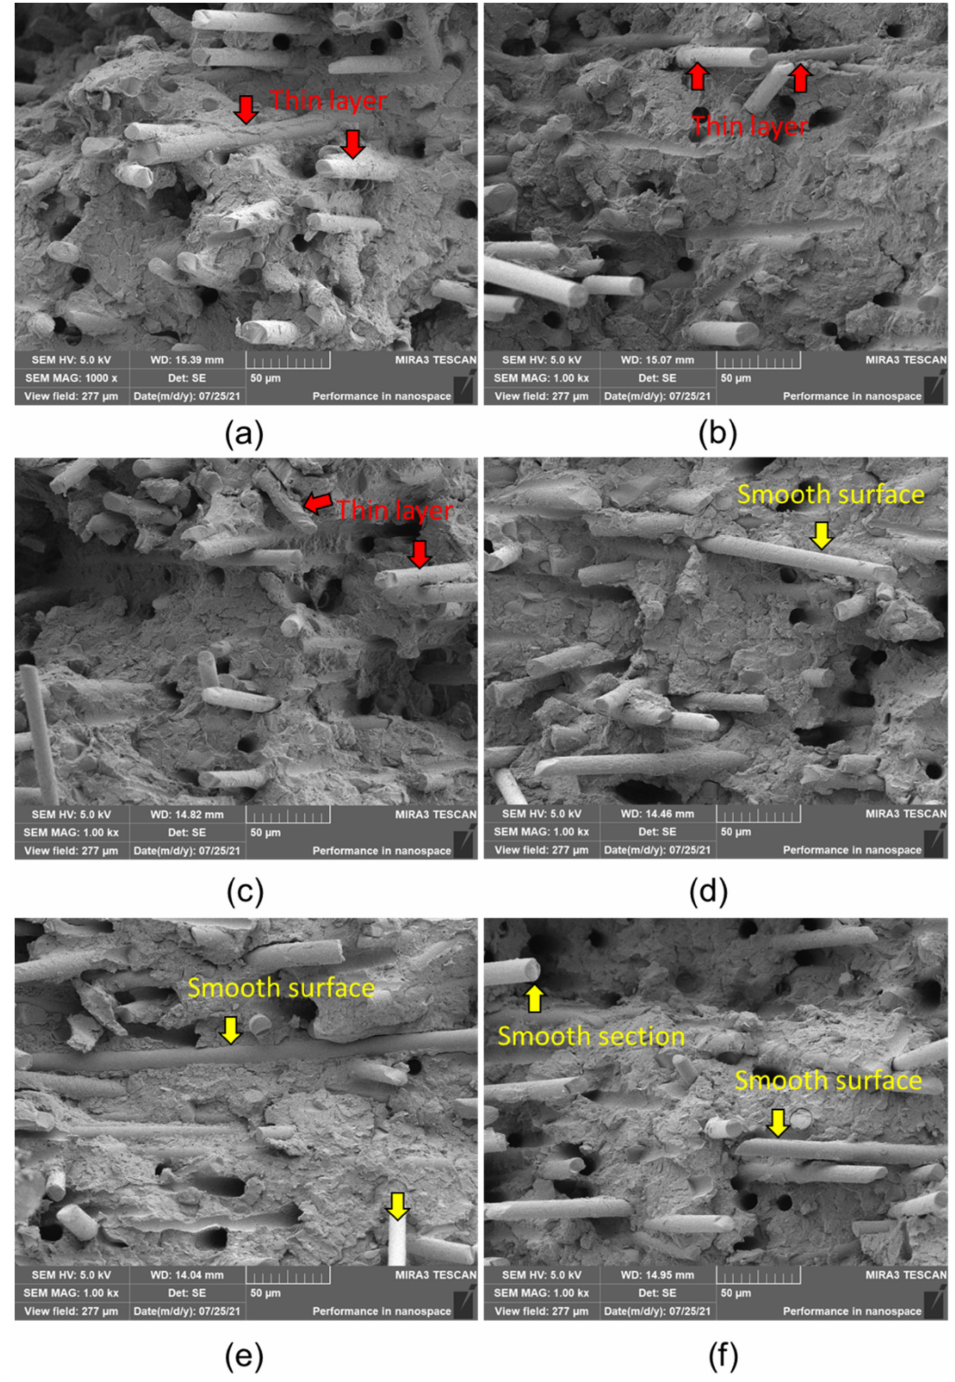
Figure 4. High-magnification images of the fracture surfaces: ( a ) GF/PPS-0, ( b ) GF/PPS-85, ( c ) GF/PPS-100, ( d ) GF/PPS-115, ( e ) GF/PPS-130, ( f )